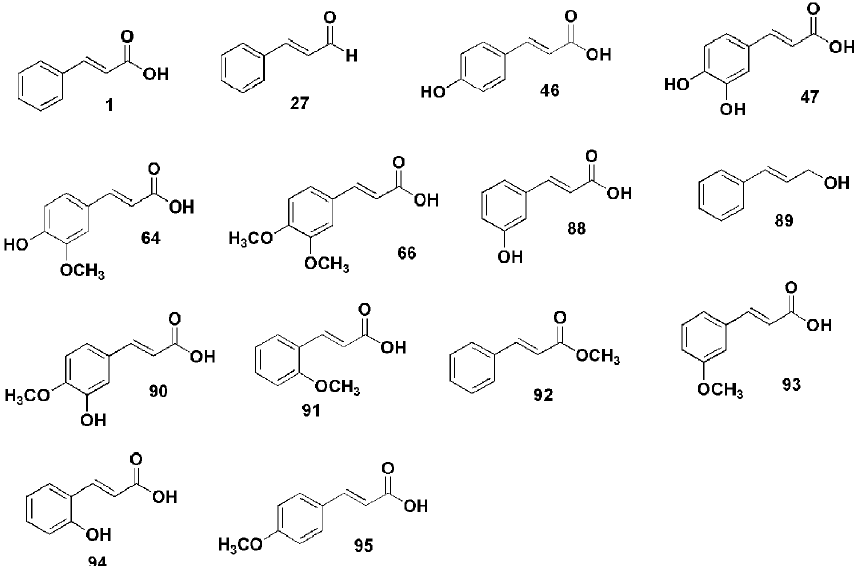
Figure 24. Structures of cinnamic acid derivatives effective against Protein Tyrosine Phosphatase 1B (PTP1B) [13].